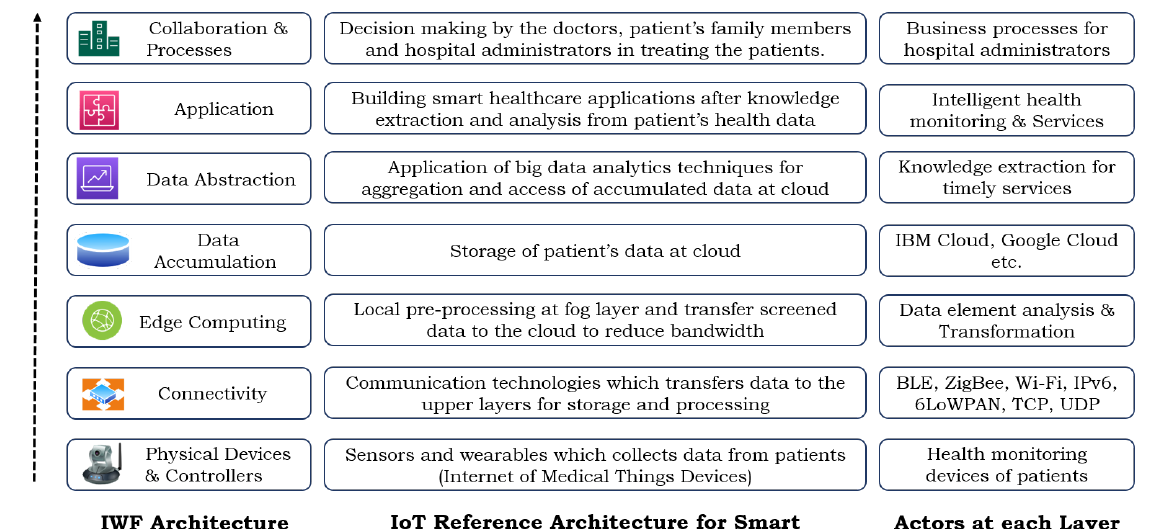
Figure 14. Smart Healthcare Reference Architecture